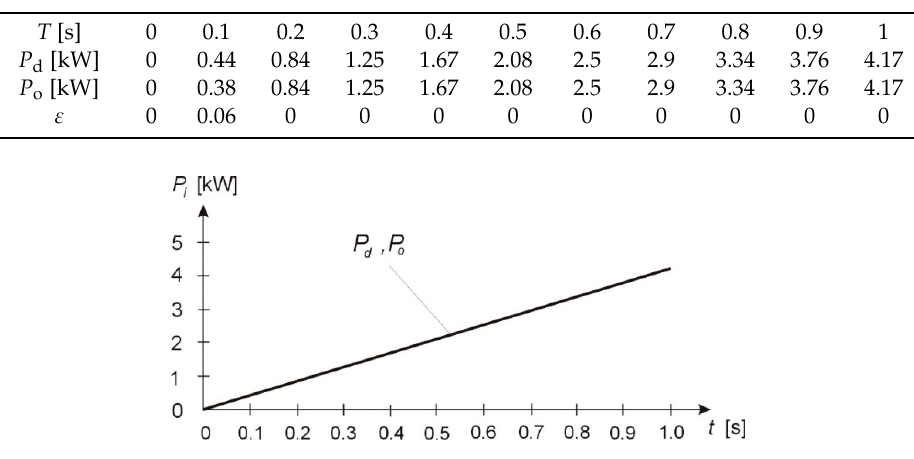
Table 1. Power consumed by the machine tool motor during cutting.